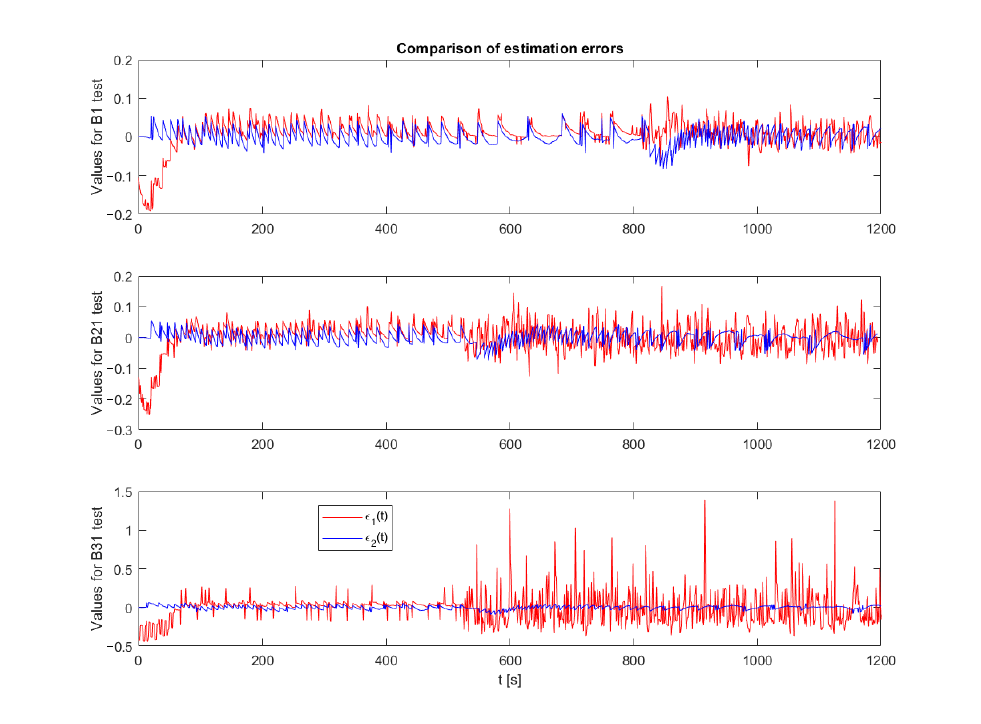
Figure 9. Comparison of estimation errors from B1, B21, and B31 experiments for model (10) (red) and (12) (blue).